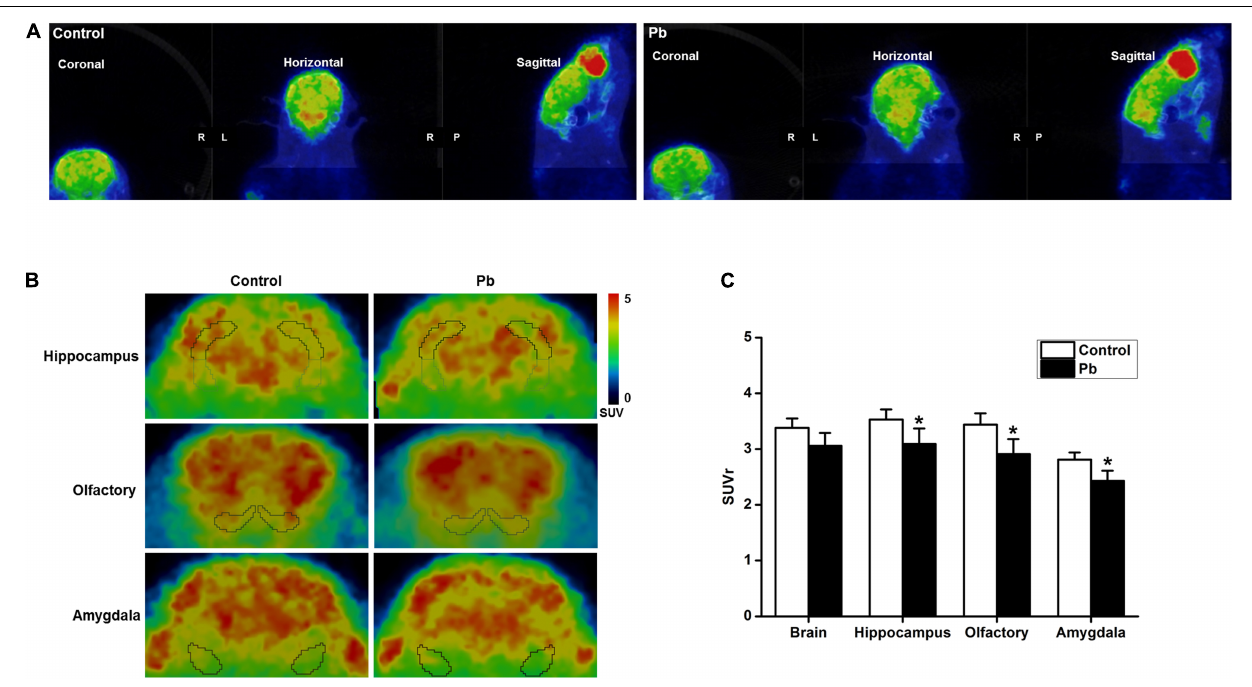
FIGURE 3 | Effect of low-level gestational Pb exposure on glucose uptake in rat brain. (A) Representative images of experimental rat brains. (B) Representative images of glucose uptake in different brain areas ([18F]-FDG microPET/CT) in the experimental rats at the last scanning point. (C) Statistical analysis of PET-CT scanning data. PET-CT results indicated that maternal Pb exposure at a low level significantly reduced the level of glucose metabolism in the rat hippocampus. * p < 0.05, n = 6 per